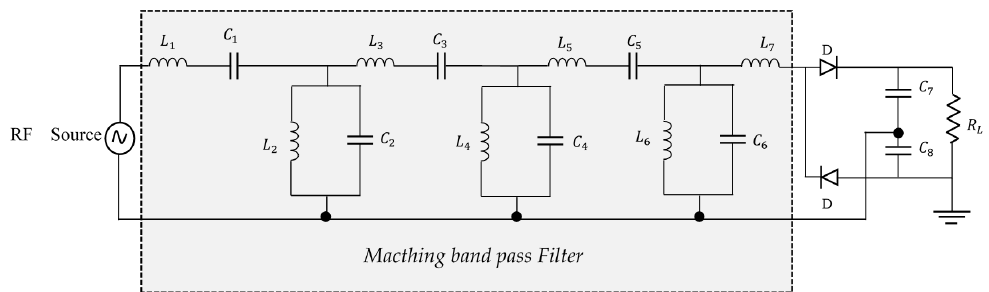
Figure 18. Rectifier with matching circuit.